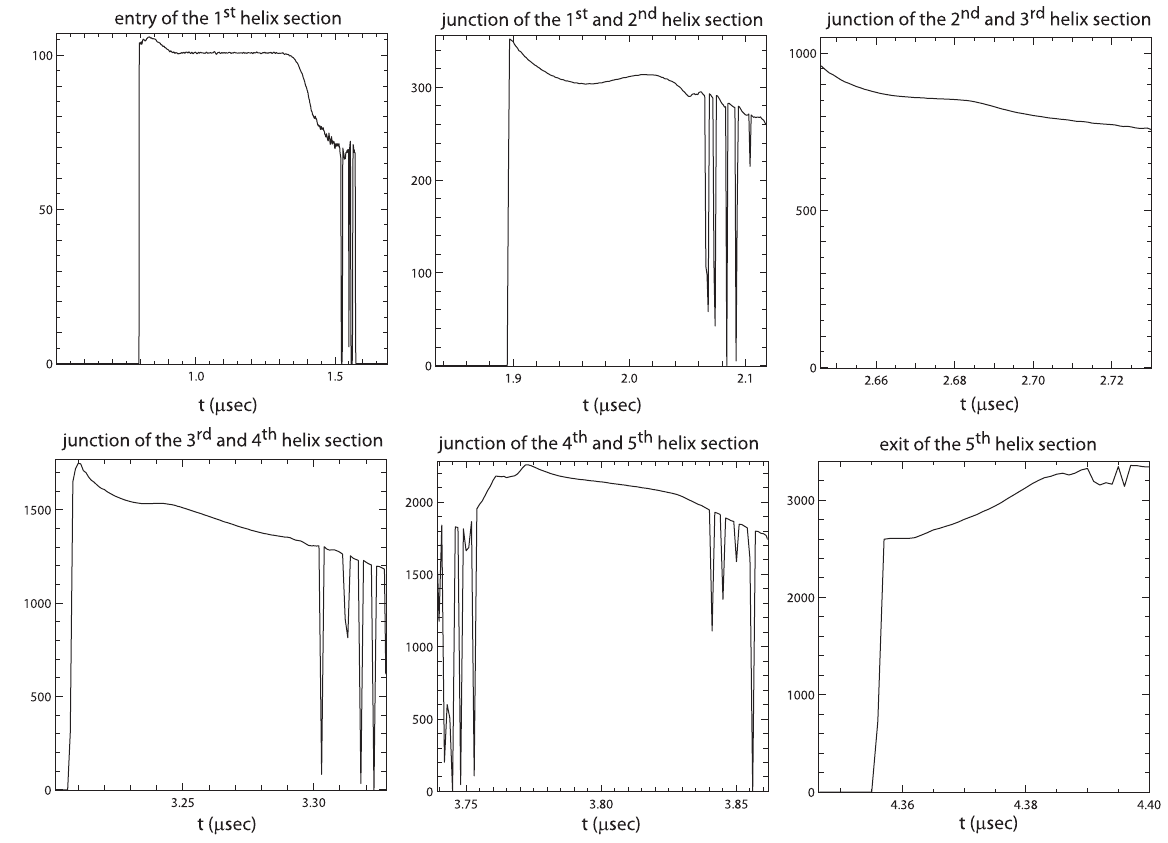
FIG. 11. The energy (in keV) of the ion beam versus time at various positions outside the helices.